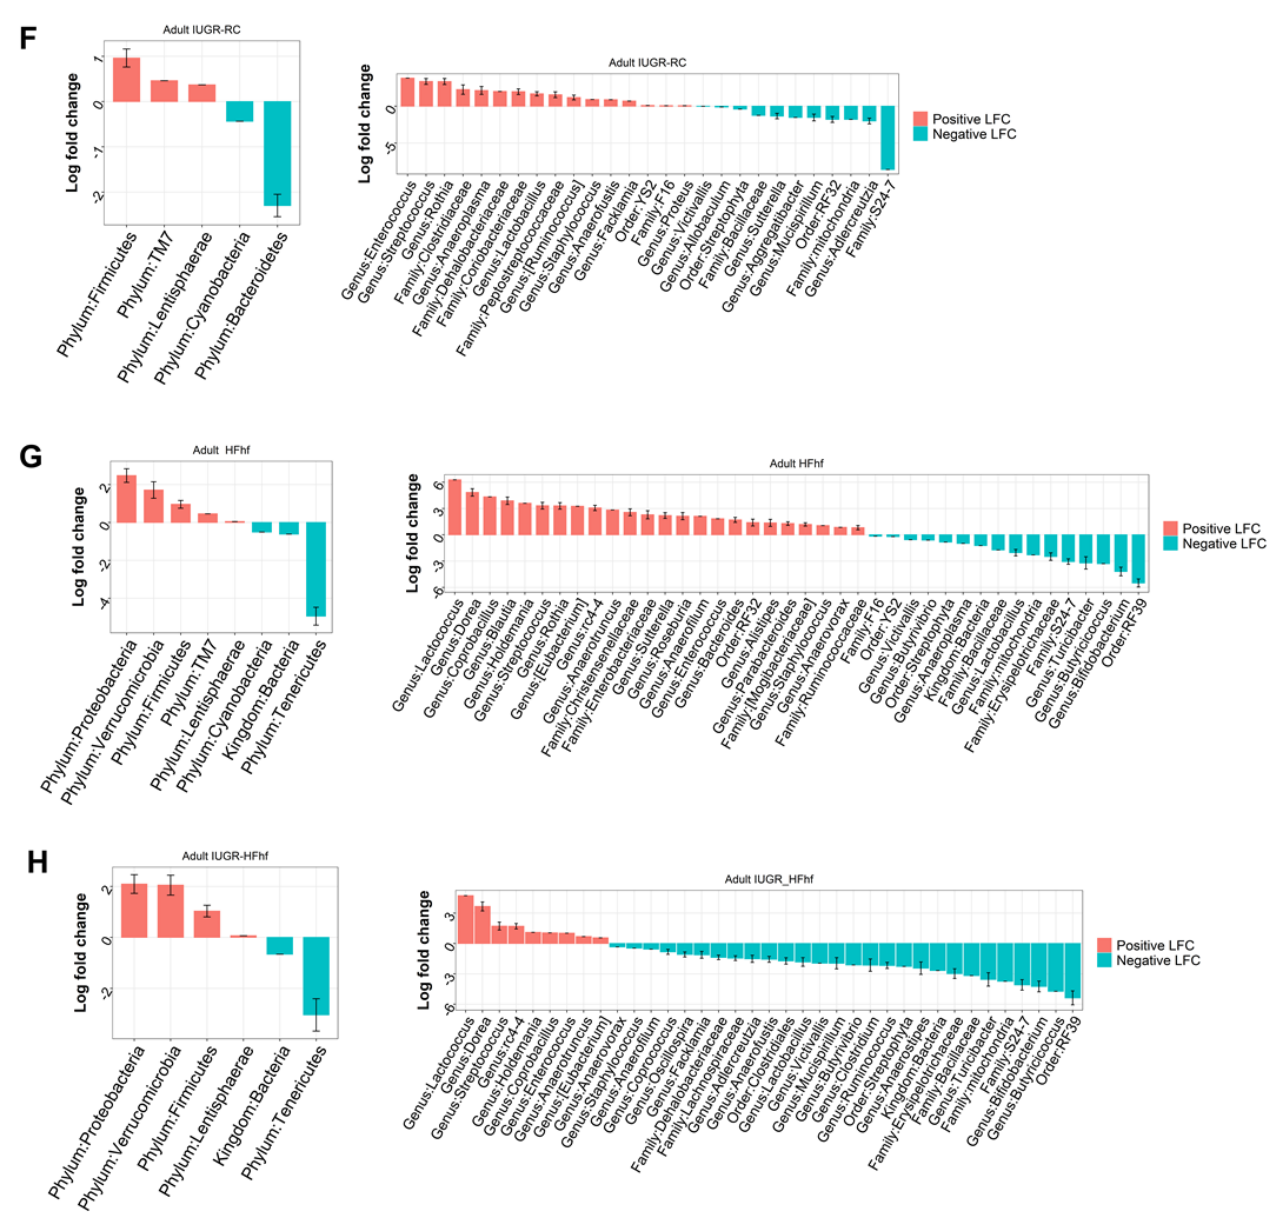
Figure 6. Violin plots showing gut microbial alpha diversity in the adult offspring (180d) ( A – D ) with four different metrics. Kruskal – Wallis p -values are denoted for each comparison with post hoc Dunn test for comparison between different dietary groups. Significance levels are marked as *** p < 0.001, **** p < 0.0001. n.s., not statistically significant; ( E ) Principal coordinates analysis of Bray – Curtis dissimilarity based on 16S rRNA gene profiling of feces collected from the adult offspring (180d) of different dietary groups. ( F – H ) Evaluation of the relative abundance of microbial taxa in different dominant diet categories using differential analysis between IUGR and CON (F), between HFhf and CON ( G ) and between IUGR-HFhf and CON ( H ). The bars represent log2 fold change. Only microbial taxa with significant fold changes ( p < 0.05) at the phylum ( left ) and genus ( right ) levels are shown.